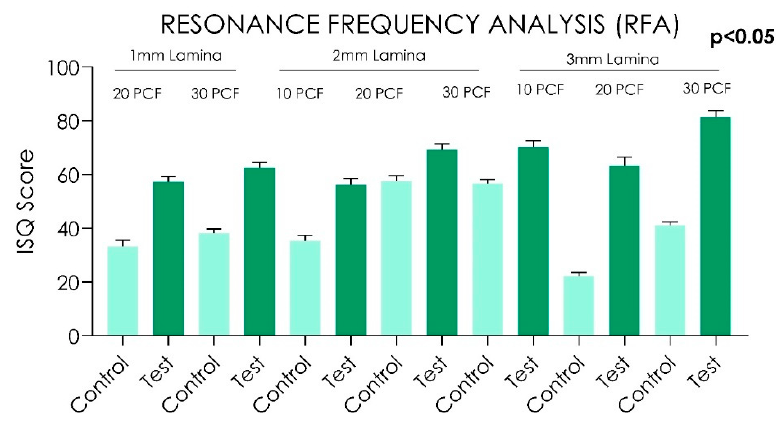
Figure 8. RFA values for Test Implants and Control Implants in different experimental conditions.